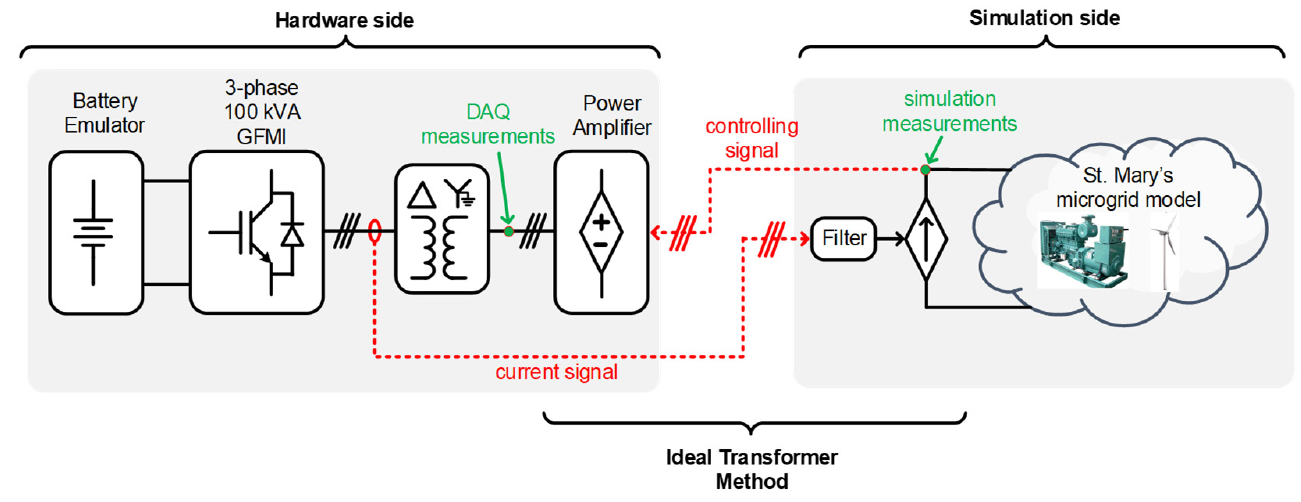
Figure 9. Power Hardware-in-the-Loop Setup for Grid Forming Inverter Experimental Testing.